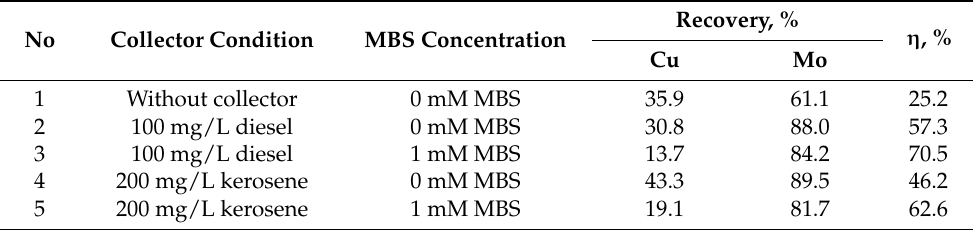
Table 2. Recovery of chalcopyrite (Cu) and molybdenite (Mo) and Newton efficiency ( η ) under the optimal condition of diesel oil and kerosene.